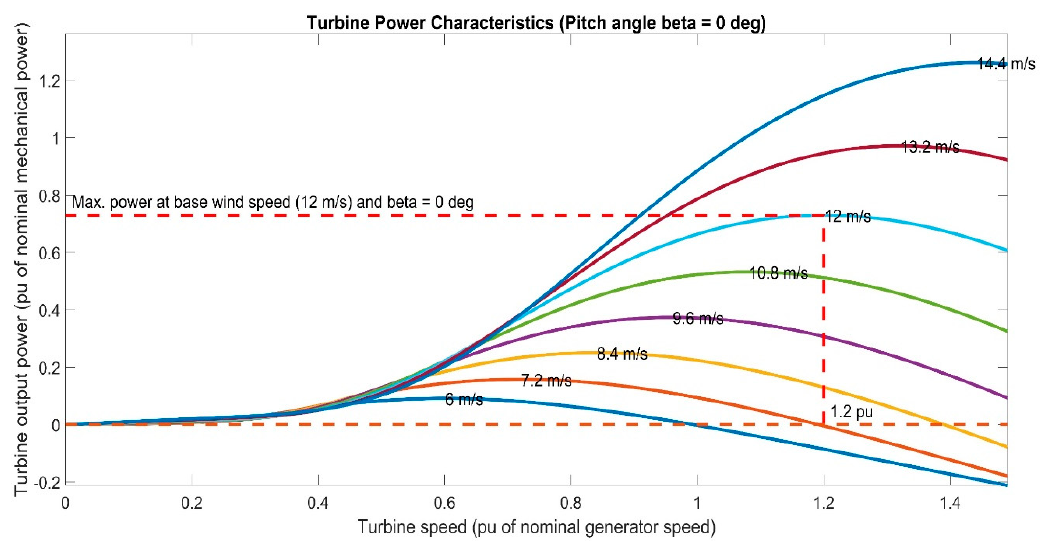
Figure 7. Power characteristic curve for a wind turbine. Table 2. Electrical parameters of wind turbine.